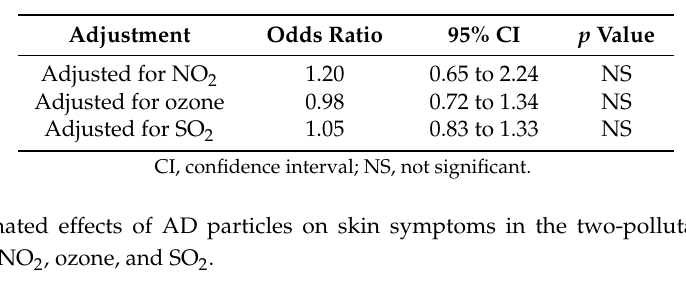
Table 4. Estimated effects of PM 2.5 on skin symptoms in the two-pollutant model after adjustment for NO 2 , ozone, and SO 2 .